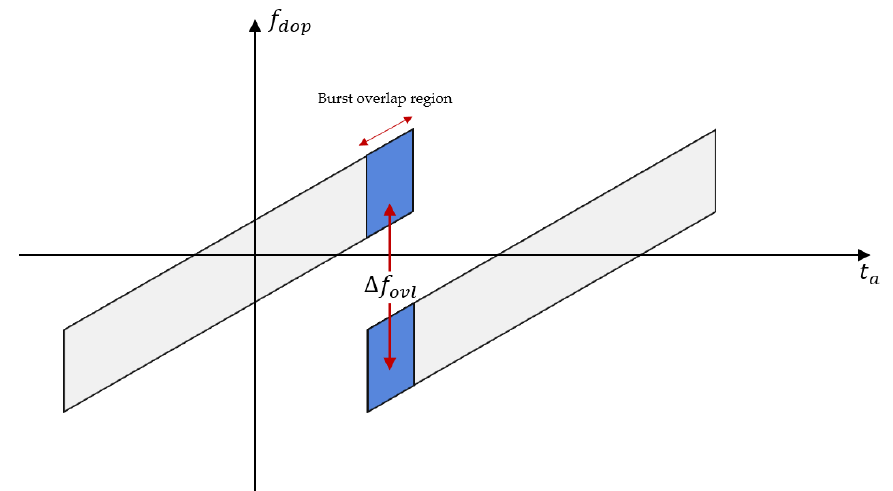
Figure 19. Time-frequency diagram of two consecutive focused bursts sketching the enhanced spectral diversity (ESD) approach. The targets located in the overlapped region (shown in blue) have a large spectral separation ∆𝑓 𝑜𝑣𝑙 .